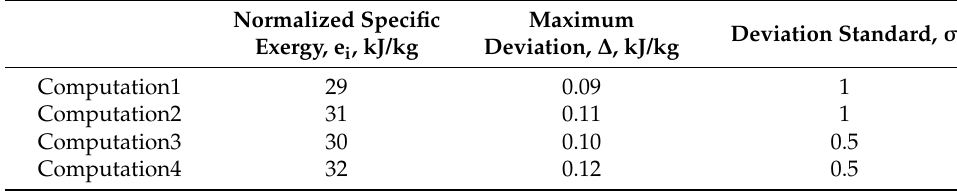
Figure 13. Results of using the new mathematical modeling (Computation 1 according to Table 6). Table 6. Results of analytical calculations according to the developed method.